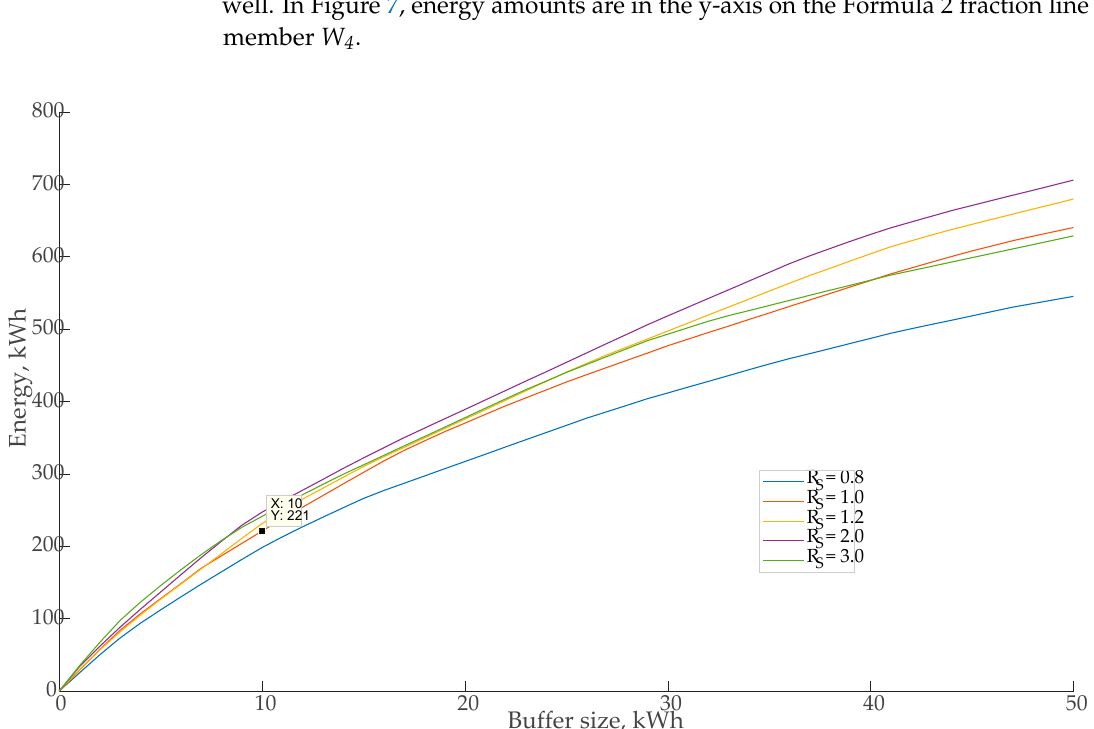
Figure 7. Energy from buffer battery (BB) to microgrid